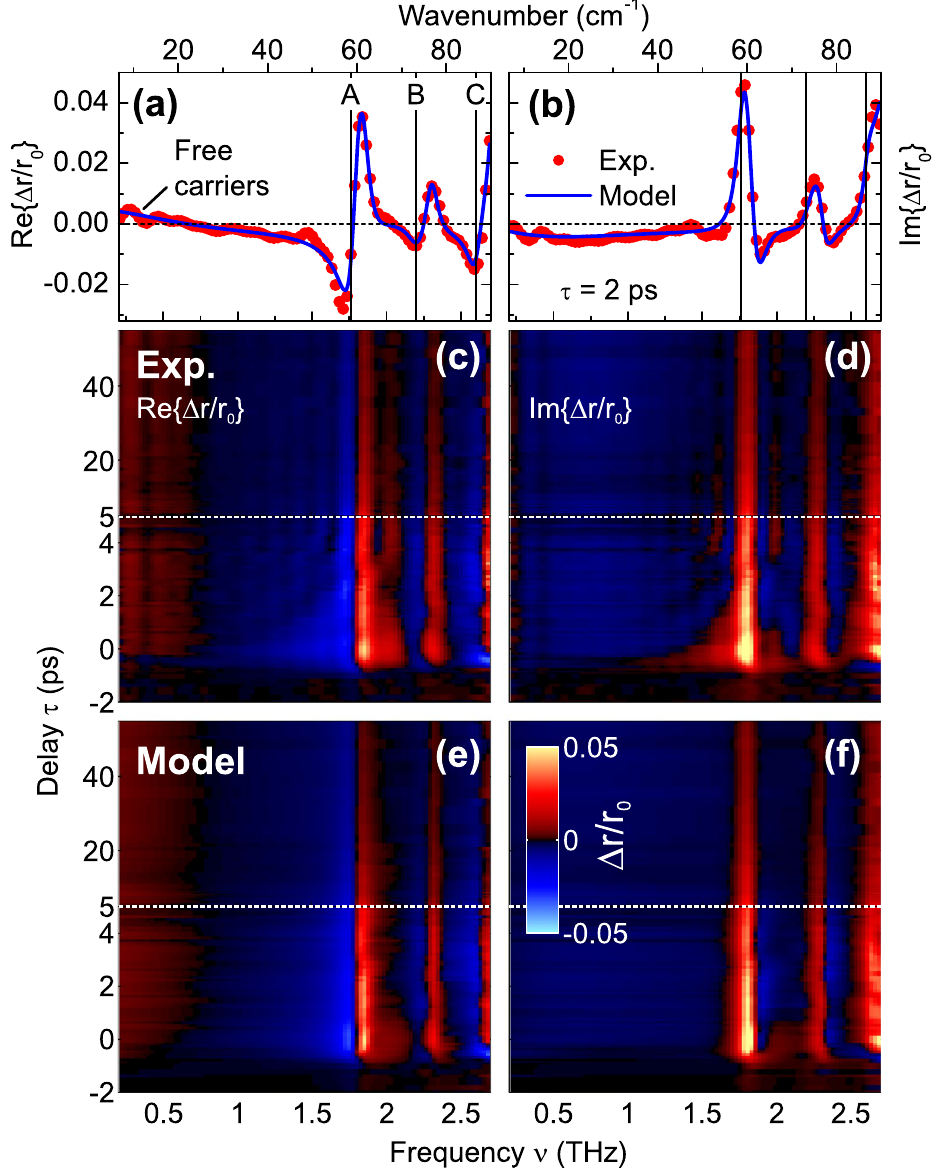
Figure 3. Time-resolved phase-phonon spectra and model analysis. Differential field reflectivity spectra Δ r / r ∝ Δ σ /( ε − 1) at T = 50 K (left graphs Re{ Δ r / r Δ r / r 0 r 0 }; right graphs Im{ 0 }). ( a , b ) For pump-probe delay τ = 2 ps, including both experimental data (points) and fitted model (see text). The GS frequencies of the three main bands (labeled A–C) from the OP-TP analysis are included as vertical lines. ( c , d ) Full experimental data Δ r ( ν , τ )/ r ν ) obtained from Fourier analysis of each row in Fig. 2(c); ( e , f ) corresponding model 0 (